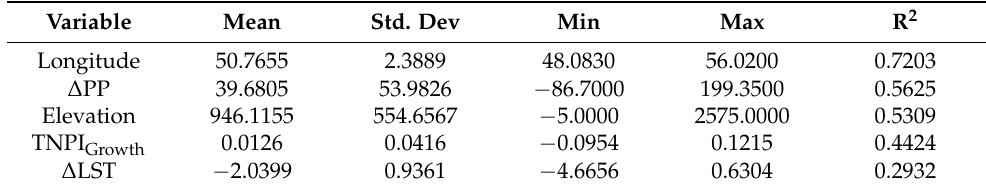
Figure 4. Longitudinal variations of ( a ) MODIS-derived TNPI Growth , ( b ) MODIS-derived change in land surface temperature ( ∆ LST), ( c ) ERA-5-derived change in precipitation ∆ PP, and ( d ) SRTM-derived Elevation maps for Hyrcanian forest. Table 3. Overall descriptive statistics of different attributes used in grouping analysis.